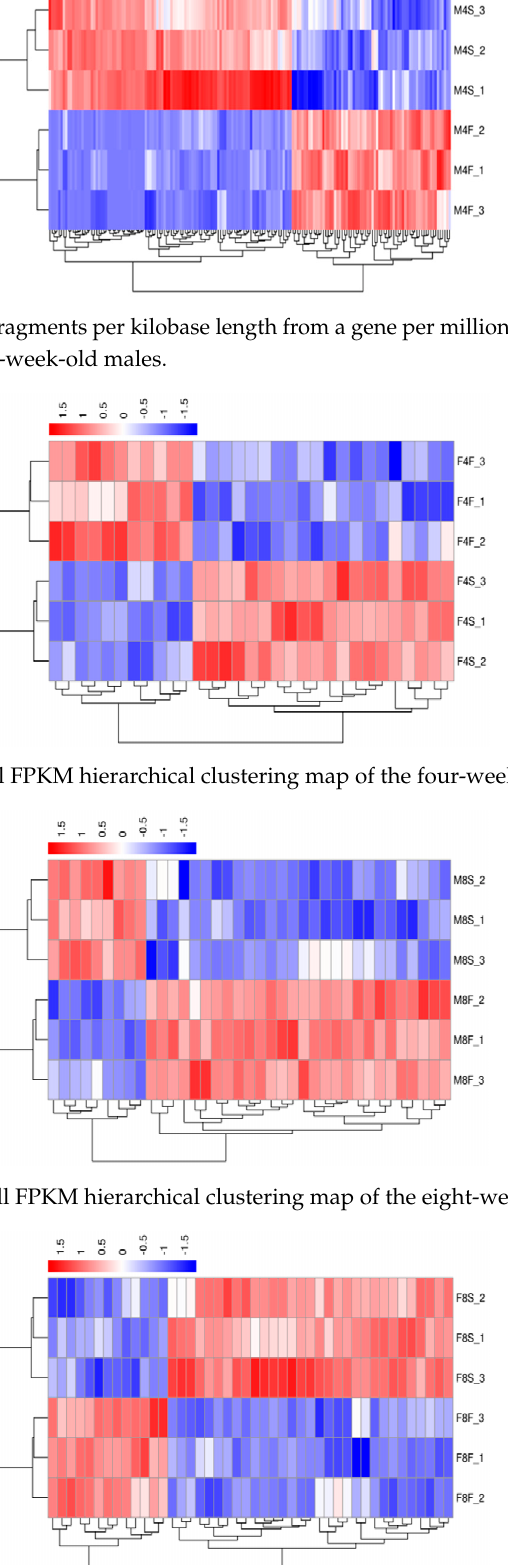
Figure 6. Overall FPKM hierarchical clustering map of the eight-week-old females.